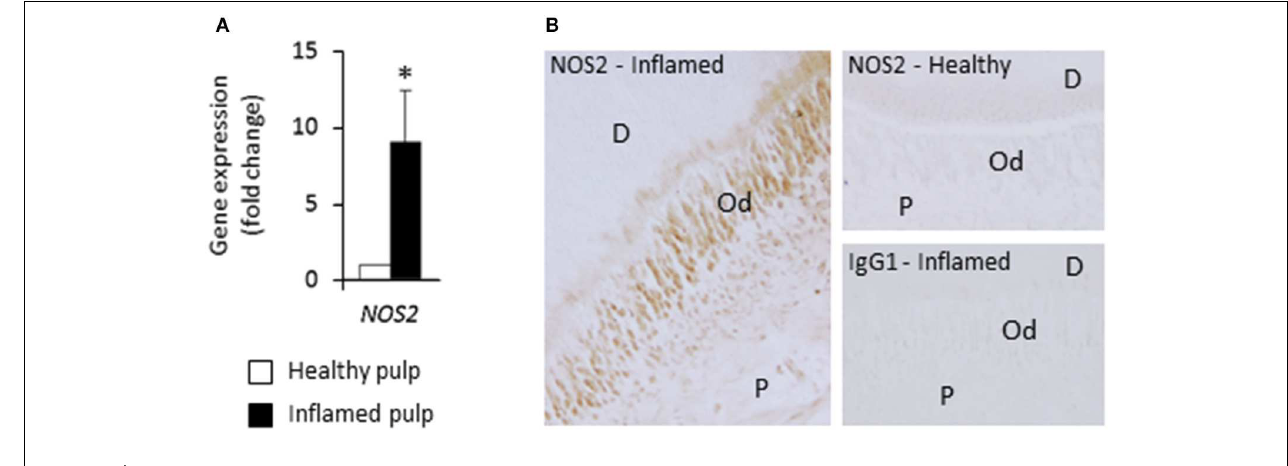
FIGURE 4 | NOS2 transcript and protein are up-regulated in inflamed pulps from decayed teeth compared to healthy ones. (A) Analysis of NOS2 gene expression in healthy and inflamed pulps with real-time RT-PCR ( n = 3 ). * p < 0 . 05 . (B) Immunohistochemical localization of NOS2 protein in healthy and bacteria-challenged inflamed pulps. No